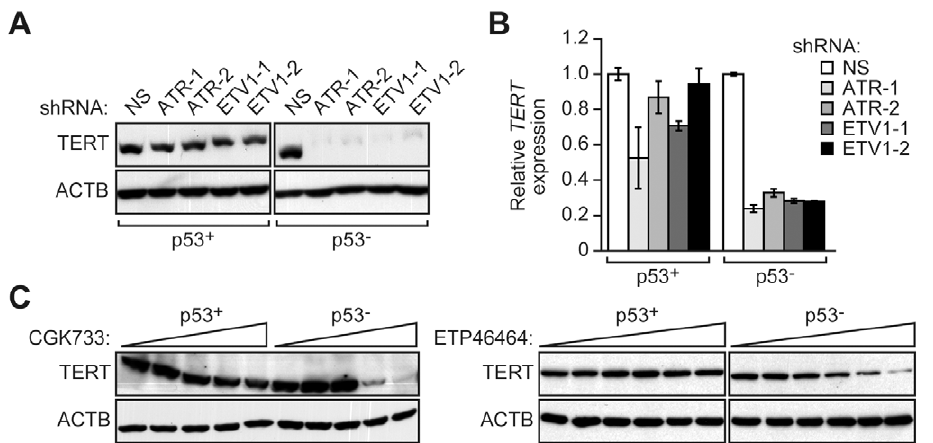
Figure 3. ETV1 and ATR are preferentially required for TERT expression in p53 2 cells. (A) Immunoblot analysis showing TERT levels in p53 + and p53 2 HCT116 cells expressing NS, ATR or ETV1 shRNAs. The results using two unrelated ATR or ETV1 shRNAs are shown. b -actin (ACTB) was monitoring as a loading control. (B) qRT-PCR analysis monitoring TERT expression in p53 + and p53 2 HCT116 cells expressing NS, ATR or ETV1 shRNAs. TERT expression was normalized to that obtained with a NS shRNA, which was set to 1. Error bars represent SD. (C) Immunoblot analysis showing TERT levels in p53 + and p53 2 HCT116 cells treated with the ATR inhibitor CGK733 (left; 0, 2, 3, 4, and 5 m M) or ETP46464 (right; 0, 0.5, 1, 2, 4 and 8 m M).